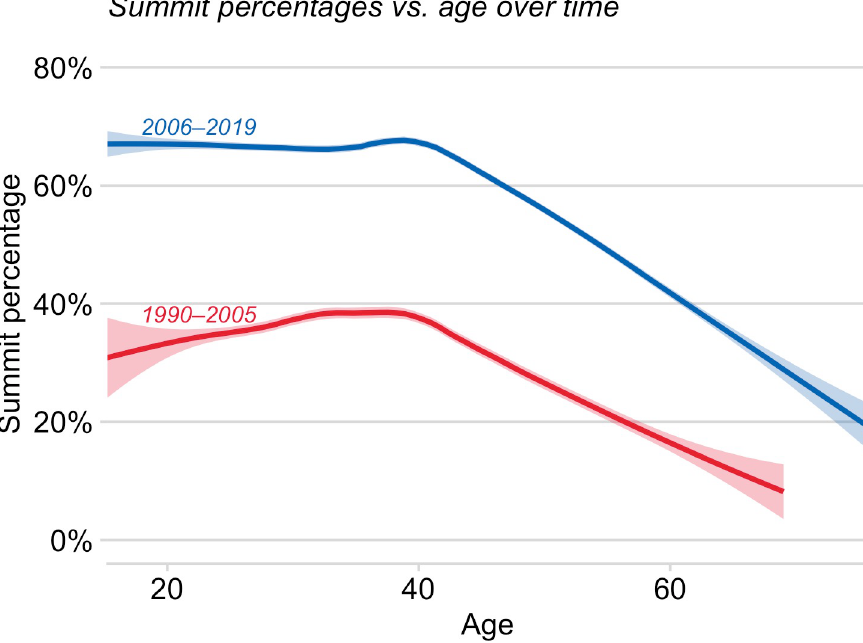
Fig 2. Fitted probabilities (GAM) of summiting vs. climber age for early (1990–2005, red) and recent (2006–2019, blue) cohorts. Probabilities of summiting declined for climbers older than ~ 40, but recent climbers of all ages had greatly elevated probabilities of summiting relative to early climbers. Solid lines are from local linear smoothing, and the adjacent shading represents the 95% confidence region for the expected summit probability as a function of age.